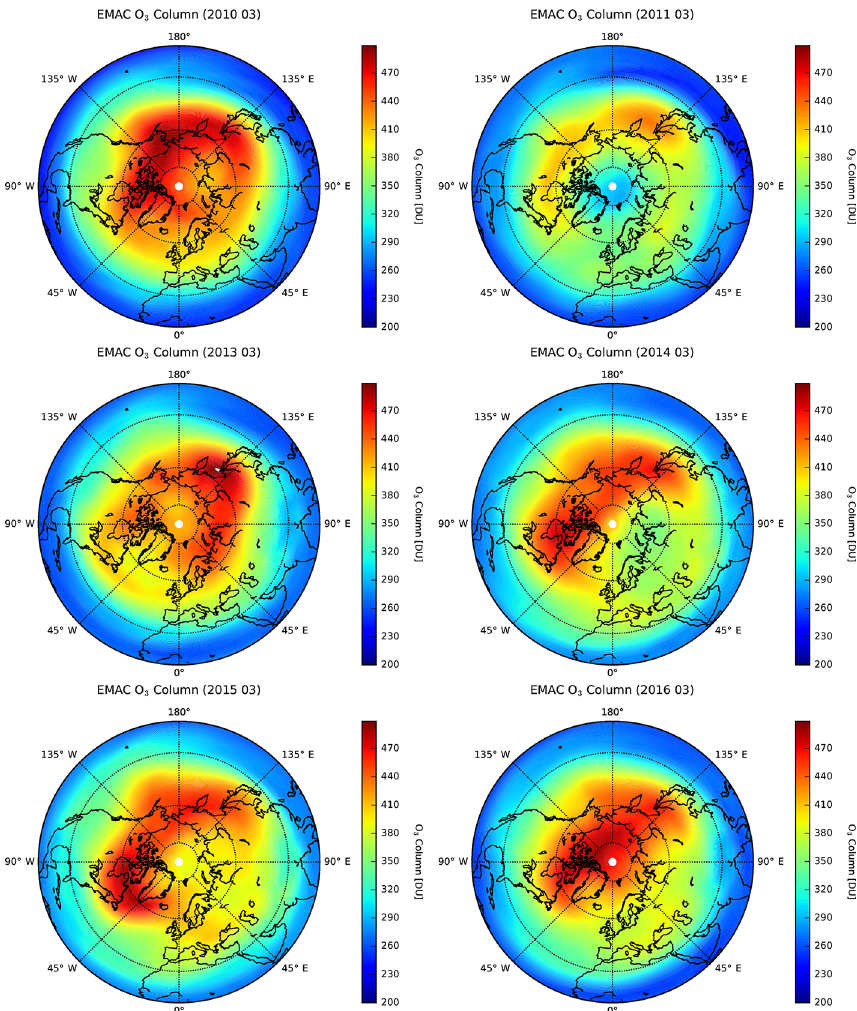
Figure 9. Total ozone column (March monthly mean) from EMAC for the years 2010–2016 (results from the EMAC T42L90 simulation are shown